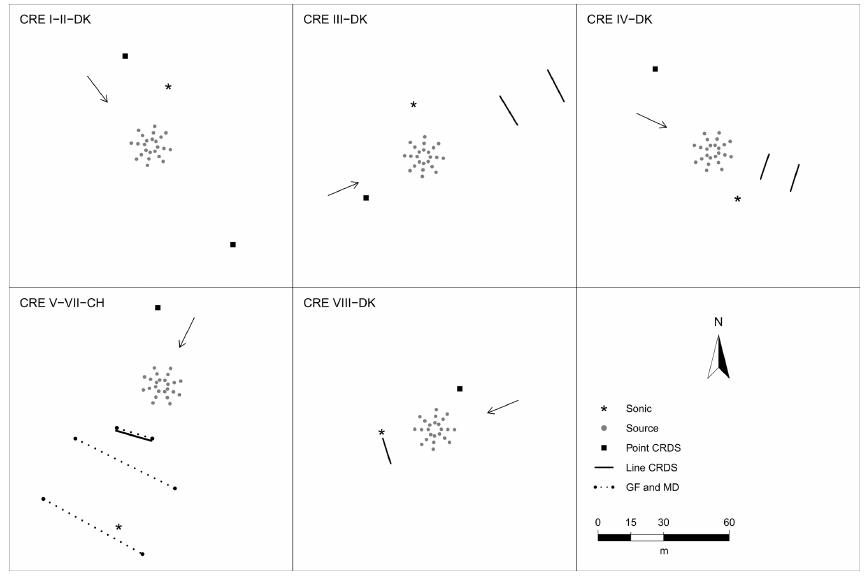
Figure 1. Position of the orifices of the artificial source, ultrasonic anemometer (sonic), and the concentration analyzer used in the eight controlled-release experiments (CRE) of this study. Three types of analyzers have been used: cavity ring-down spectrometer (CRDS), Gas- Finder (GF), and miniDOAS (MD). The arrow indicates the wind direction during each